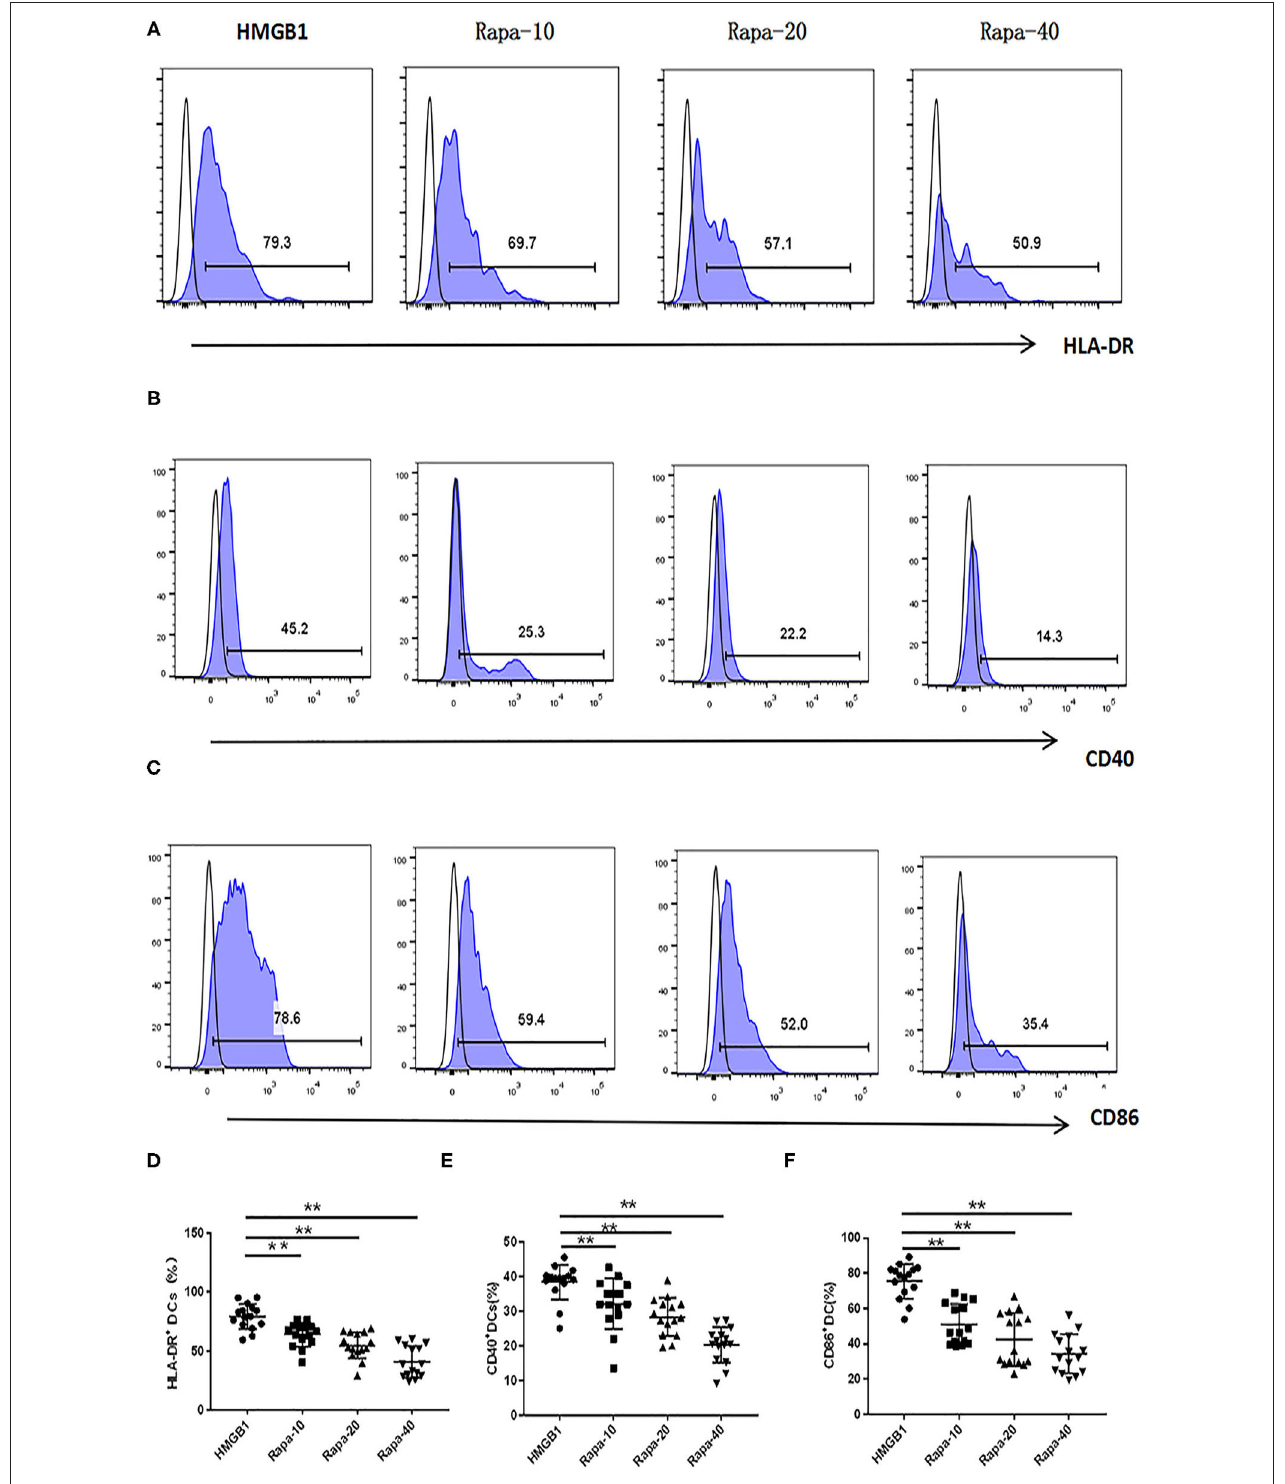
FIGURE 7 | Rapamycin can inhibit HMGB1-induced mDC expression of HLA-DR, CD40 and CD86 increase. Different concentrations of rapamycin (Rapa-10: 10ng/ml; Rapa-20: 20ng/ml; Rapa-40: 40ng/ml) were put into cultures of primary mDCs. Flow cytometry analysis of HLA-DR (A) , CD40 (B) and CD86 (C) , surface expression on each group mDCs from SLE patients. The expression of HLA-DR (D) , CD40 (E) , and CD86 (F) were decreased on mDCs through Rapa intervention compared with HMGB1 group. ** P < 0.01.